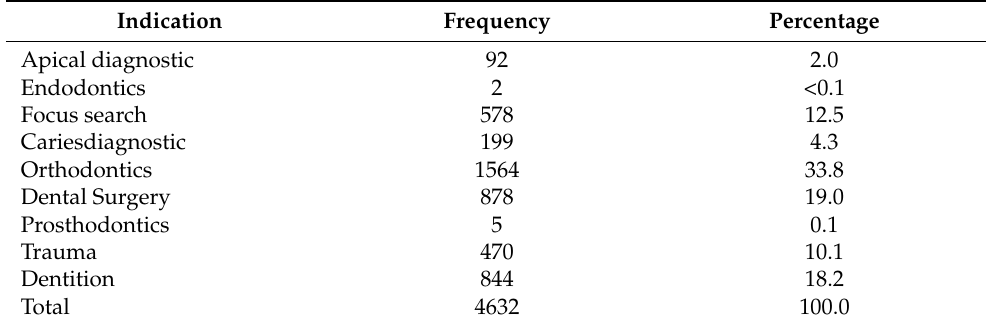
Table 4. Frequency distribution of the indication for dental